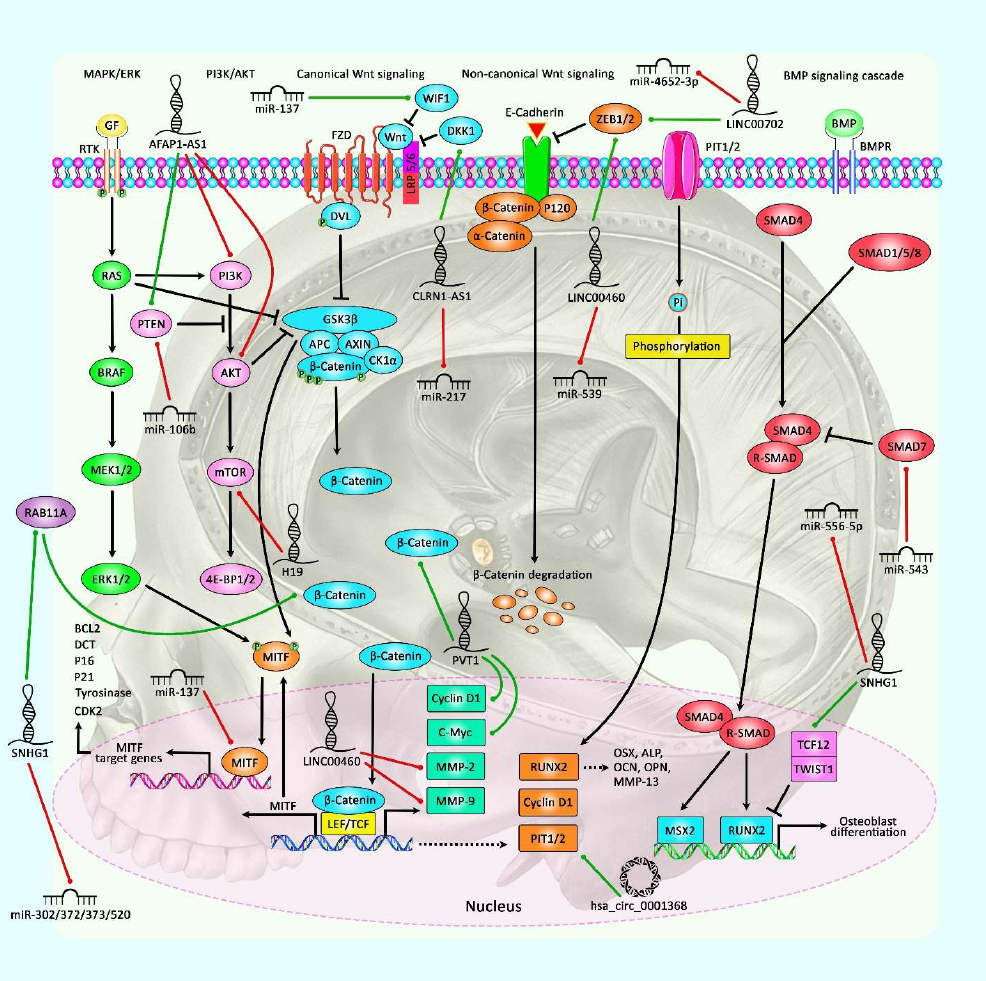
Figure 1. A schematic representation of the role of several non-coding RNAs in regulating the MAPK/ERK, PI3K/AKT, Wnt/ β -Catenin, and BMP signaling pathways in pituitary gland tumors and meningiomas. The figure represents the potential crosstalk between various signaling cascades modulated via several ncRNAs in triggering the development of tumor cells. WNT-signaling is a crucial part of the crosstalk between key oncogenic cascades involved in pituitary gland tumors. Elements of the WNT cascades both could be regulated through diverse pathways, including MAPK/ERK, PI3K/AKT, and BMP, as well as transcriptional regulators containing p53 and MITF [32]. In addition, an accumulation of β -catenin in the cytoplasm could, in turn, lead to its translocation to the nucleus, where it could create a complex with TCF/LEF to trigger the transcription of RUNX2, Cyclin D1, and PIT1/2. Additionally, RUNX2 could modulate the transcription of various targets, including OCN, OSX, OPN, MMP13, and ALP [33]. Furthermore, BMP receptors could phosphorylate receptor-SMADs upon ligand binding. TCF12 and TWIST1 are basic helix-loop-helix transcription factors that could play an effective role in heterodimerization and suppressing transcription downstream of the BMP cascade [34]. According to the current report, lncRNA AFAP1-AS1 could enhance growth and inhibit apoptosis in pituitary adenomas through promoting PTEN expression and suppressing the expression levels of PI3K and AKT in tumor cells [29]. Moreover, another research has denoted that LINC00460 could elevate meningioma progression and metastasis through promoting the expression levels of MMP-2, MMP-9, and ZEB1 by sponging miR-539 and thereby acting as an oncogenic RNA in the meningioma malignancy [35]. Moreover, based on recent study, lncRNA SNHG1 via targeting miR-556-5p could elevate TCF12 expression, thereby promoting tumorigenesis of meningioma through the Wnt signaling cascade. In fact, TCF12 expression was positively modulated via SNHG1, and TCF12 could, in turn, enhance transcription of SNHG1 through binding with the promoter region of SNHG1 [36]. Green arrows indicate the upregulation of target genes modulated via ncRNAs (miRNAs and lncRNAs); red arrows depict inhibition regulated by them. All the information regarding the role of these ncRNAs in modulating pituitary gland tumors can be seen in Tables